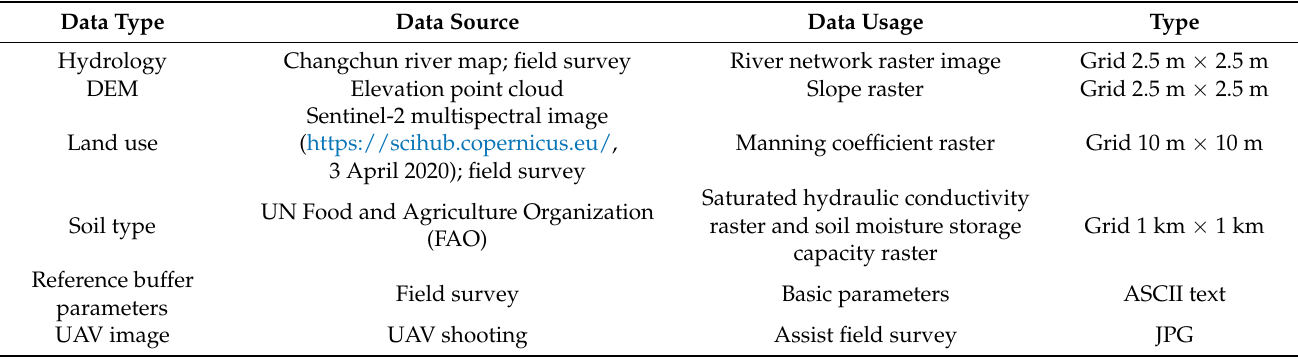
Table 2. Data sources and a detailed